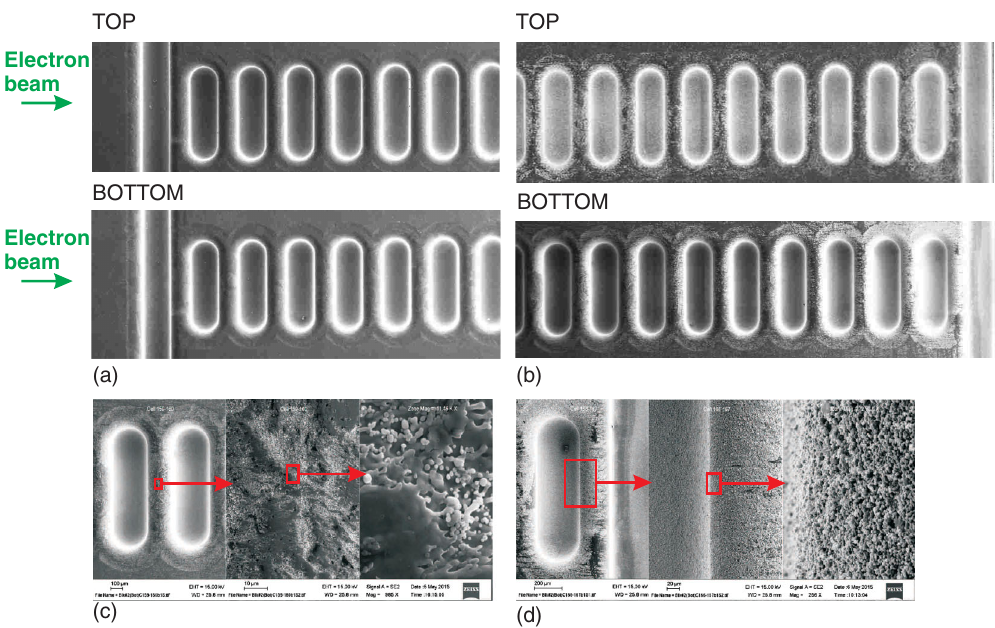
FIG. 23. SEM picture of breakdowns generated during the experiment involving the 235 GHz copper structure, driven by a bunch charge of 3.2 nC and 50 μ m length. Input part of the structure: Little damage sign, from the input coupler to cell 152 (a). Output end of the structure: Damage concentrated at output irises, the bottom part has more sputter, and all the heavy damage occurs in cells 154 – 167 (b); iris between cells 159 and 160, heavy damage (c); bottom cell 166, areas adjacent to heavy surface melting are covered with sputtered material (d).